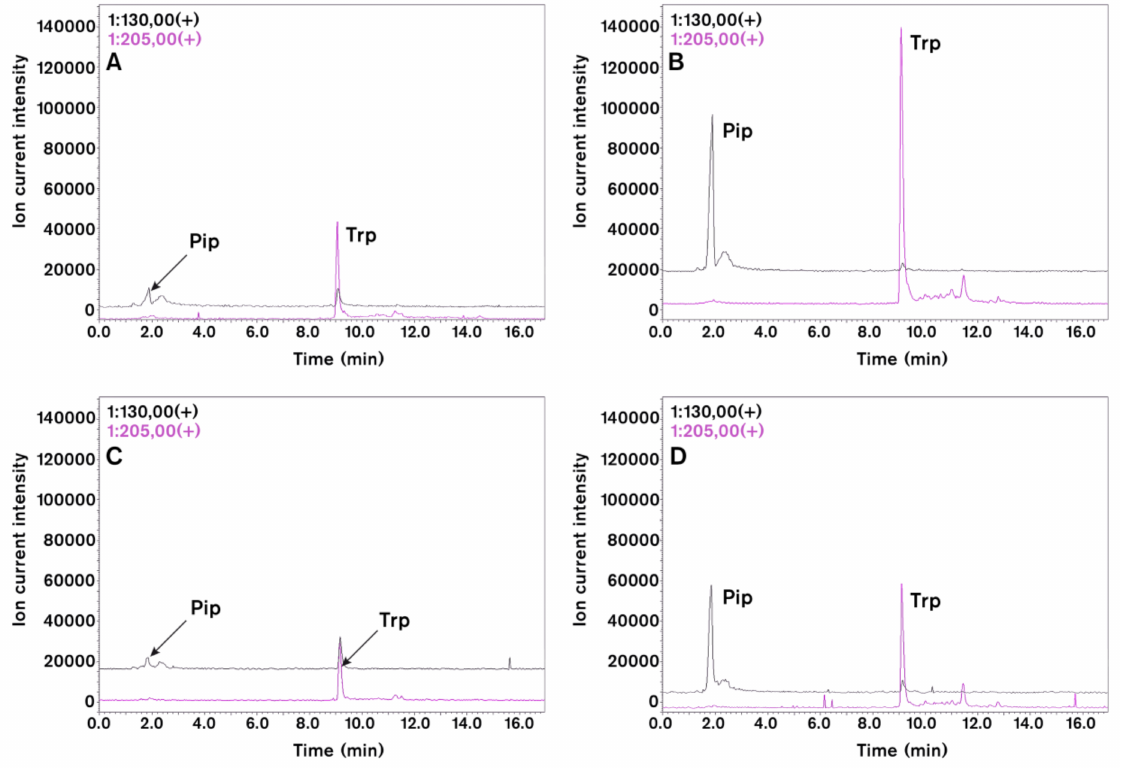
Figure 4. Effect of TMV ( A , B ) and CMV ( C , D ) inoculations on selected amino acids of tobacco leaves (4 days after viral inoculation). HPLC-MS chromatograms of pipecolic acid (Pip, m / z = 130) and tryptophan (Trp, m / z = 205) in virus infected leaves ( B , D ) as compared to control plants ( A , C ). Leaf samples (about 200 mg) were extracted with acetonitrile:water (6:4 v/v in 1.5 mL). This condition supports amino acid extraction but limits protein solubilization. HPLC-ESI-MS analyses were carried out with a Shimadzu LCMS-2020 (Shimadzu Co., Kyoto, Japan) analytical system. Chromatographic separations were performed on a SunShell C18 packed column (2.6 µ m, 3.0 mm × 100 mm) by using gradient elution (solvent A, 0.1% formic acid solution; solvent B, 0.1% formic acid in acetonitrile) under non-derivatised conditions. Ions for MS detection were obtained by positive mode of electrospray ionization (ESI). Identity of peaks were also checked by co-chromatography of samples with authentic standards (Sigma-Aldrich Co. St. Louis, MI,